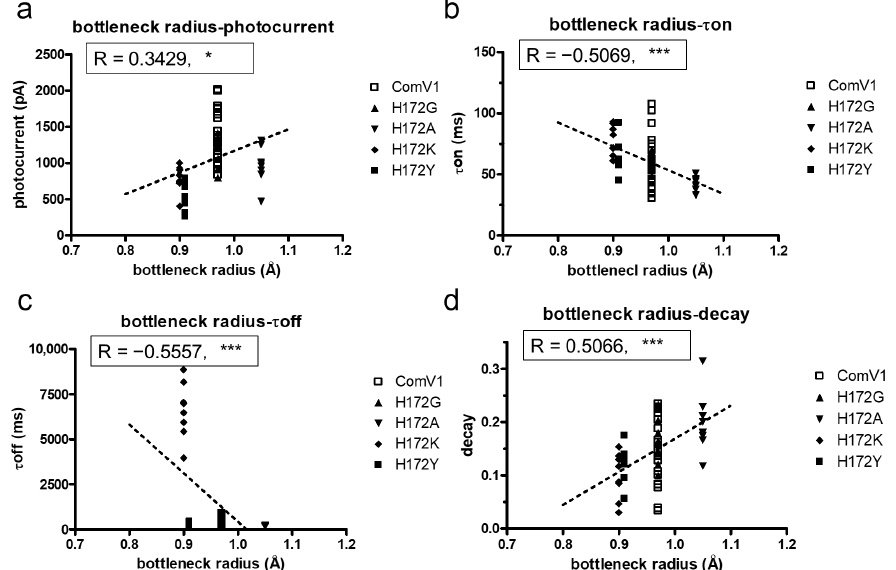
Figure 5. Correlation analysis between the ion tunnel radius and the channel properties. ( a – d ) Correlation between the radius of the bottleneck of the ion gating pathway and peak currents ( a ), τ on ( b ), τ off ( c ), and decays ( d ) at 505 nm. All data were analyzed with Pearson correlation coefficient (* p < 0.05, *** p < 0.001).